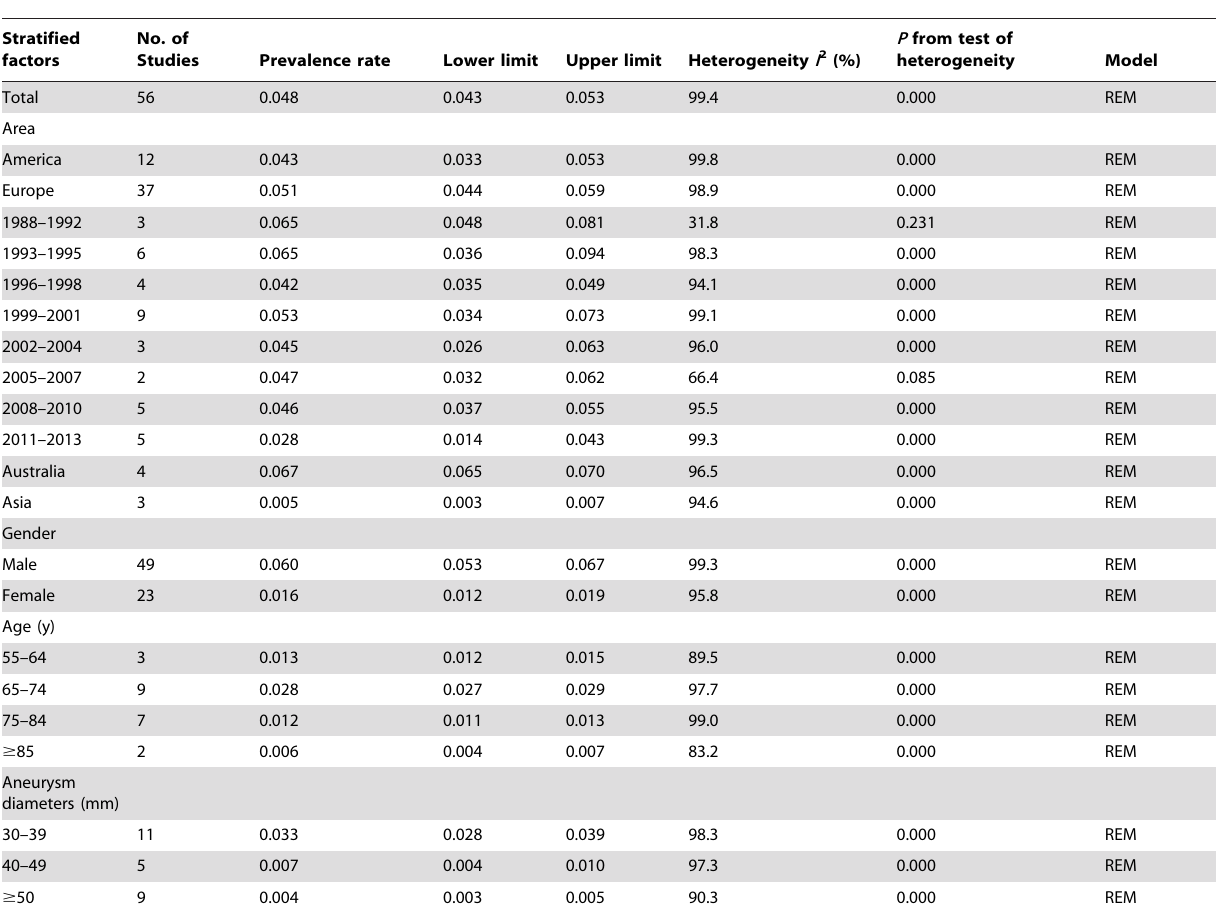
Table 2. Prevalence of abdominal aortic aneurysm in older people by different stratified factors.